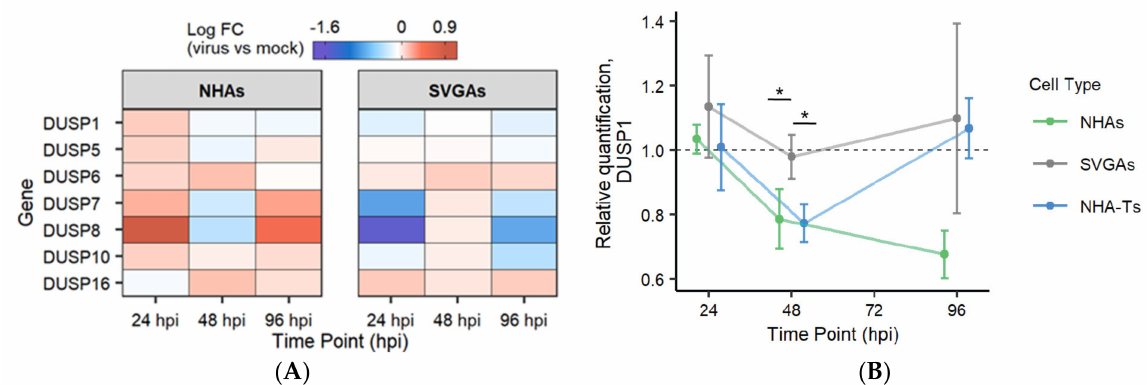
Figure 4. DUSPs were differentially expressed early during infection. ( A ) Heat map indicates the log fold change of typical DUSPs differentially expressed in NHAs and SVGAs at 24, 48, and 96 hpi, derived from the RNA-Seq data. ( B ) NHAs, SVGAs, and NHA-Ts were infected with JCPyV (MOI = 0.1 FFU/cell) or the mock-infected vehicle control at 37 ◦ C for 1 h and incubated in complete media for 0, 24, 48, and 96 h. At each time point, RNA was extracted, and host transcript levels were determined by qPCR. Data represent the relative quantification of DUSP1 transcript in infected cells compared to uninfected cells, first normalized to the Ct values of GAPDH for each treatment (2 − ∆∆ CT ). Error bars indicate SD. Data are representative of the average fold change calculated from triplicate samples from three independent experiments. One-way analysis of variance (ANOVA) was used to determine statistical significance comparing the relative quantification of DUSP1 in NHAs, NHA-Ts, and SVGAs at each timepoint. *, p <